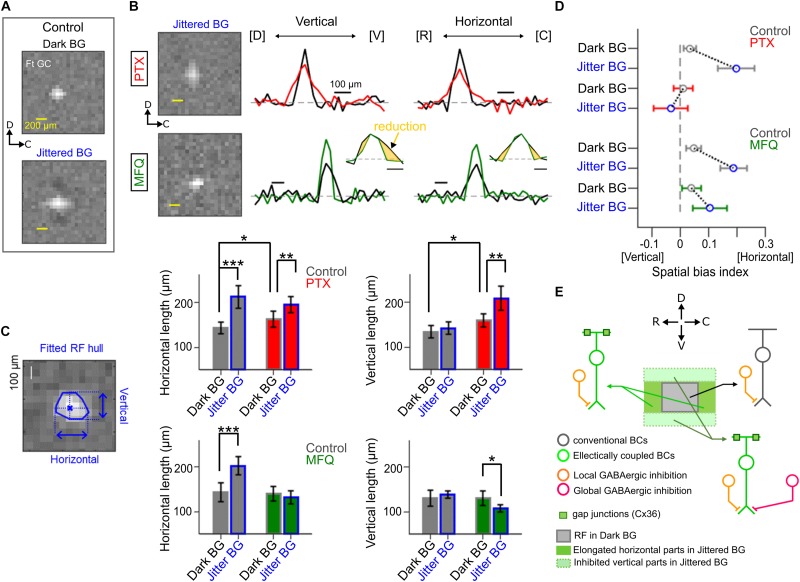
Effects of pharmacological blockade of GABAergic inhibition and electrical coupling. (A) The spatial RF profile of a Ft GC under the Dark and Jittered BG conditions in control solution. (B) The spatial RF profile in the presence of picrotoxin (PTX, 100 μM, red) and mefloquine (MFQ, 10 μM, green). Left, the estimated RF under the Jittered BG condition. Right, the spatial RF profile along the vertical (dorsal–ventral) and horizontal (rostral–caudal) axes in control (black), PTX (red), and MFQ (green) solutions. (C) Left, a schematic for calculation of the horizontal and vertical lengths of the RF (blue). Right, horizontal and vertical lengths of the RF under the Jittered (blue) and Dark (gray) BG conditions in control (gray), PTX (red) and MFQ (green) solutions. 7 Ft GCs. (D) Spatial bias index (see section “Method Details”) under the Jittered (blue) and Dark (gray) BG conditions in control (gray), PTX (red), and MFQ (green) solutions. Circle and error bars, mean ± SD. 7 Ft GCs. (E) A schematic model to explain the horizontal RF elongation. A Ft GC receives excitatory inputs from distinct BC populations: conventional BCs (dark gray) which evoke small and slow EPSCs, and electrically coupled BCs (right green) which evoke large and fast EPSCs under the Jittered BG condition. BCs receive GABAergic inhibition (orange) from local ACs which are activated by local stimulation under the Dark BG condition. The electrically coupled BCs at the dorsal and ventral sides additionally receive global GABAergic inhibition (magenta) from wide-field (or electrically coupled) ACs which are activated by the Jittered BG. ∗p < 0.05; ∗∗p < 0.01; ∗∗∗p < 0.001.